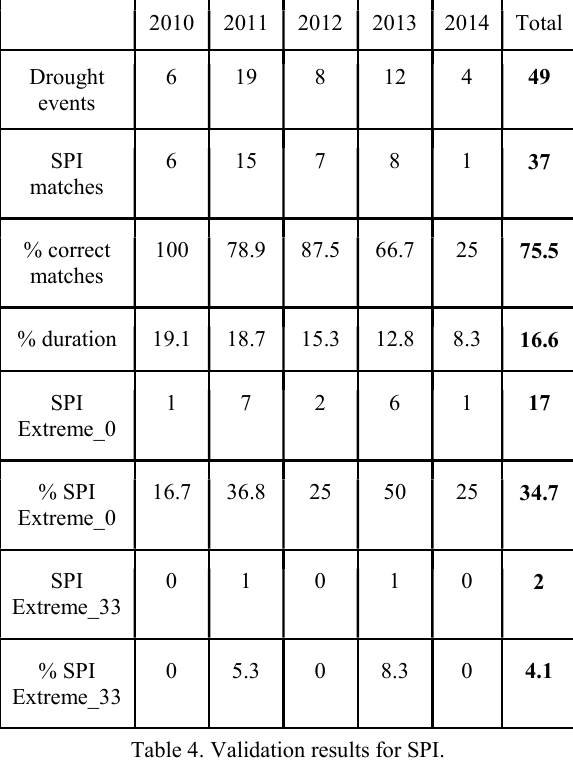
Table 4. Validation results for